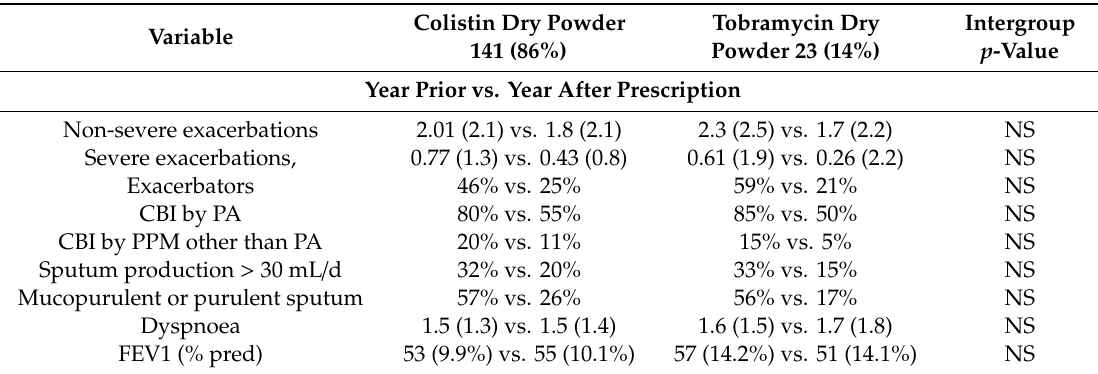
Dry powder inhaled antibiotics (DPIA) E ffi cacy in patients under colistin and tobramycin